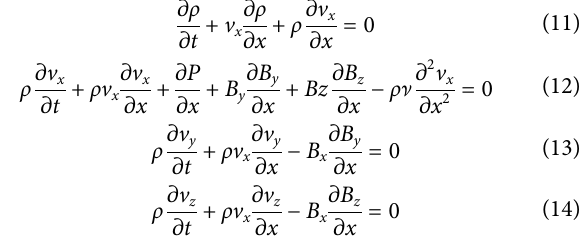
Frontiers in Astronomy and Space Sciences |